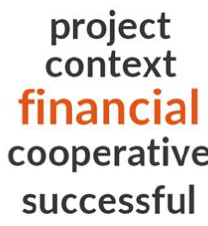
Figure 3. Word cloud of phrases that make up the Risk category. Source: Own research. The more often a word appears, the larger the font.